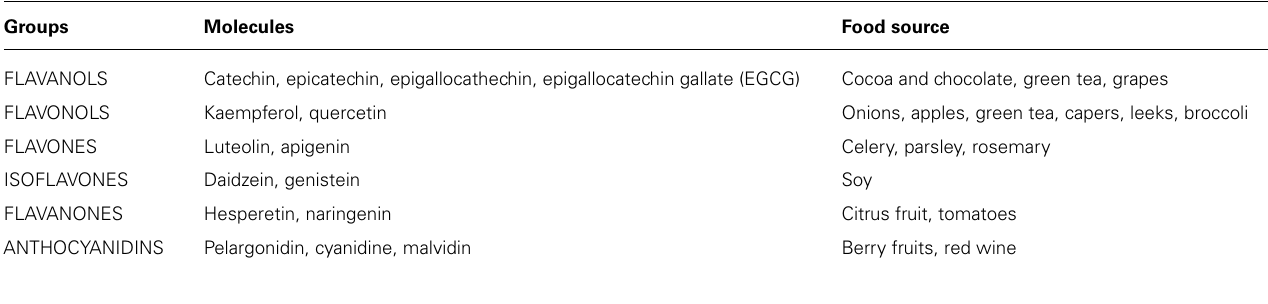
Table 1 | Flavonoid chemical subgroups and relative food sources.